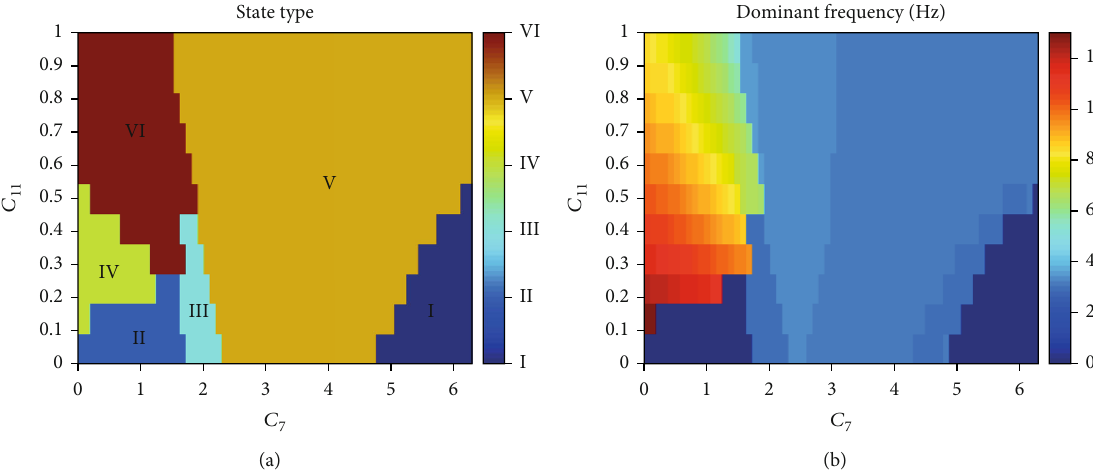
Figure 4: Di ff erent fi ring states (a) and variations of corresponding dominant frequencies (b) are shown on the parameter plane ( C where we can observe rich fi ring states such as I (high saturated state), II (low saturated state), III (SWD), IV (tonic), V (low-frequency clonic), and VI (high-frequency clonic). In addition, the dominant frequencies of states I and II are 0 Hz, of states III and V are between 2Hz and 4Hz, and of state VI are between 5Hz and 10Hz, while the dominant frequencies of state IV are greater than 10 Hz.